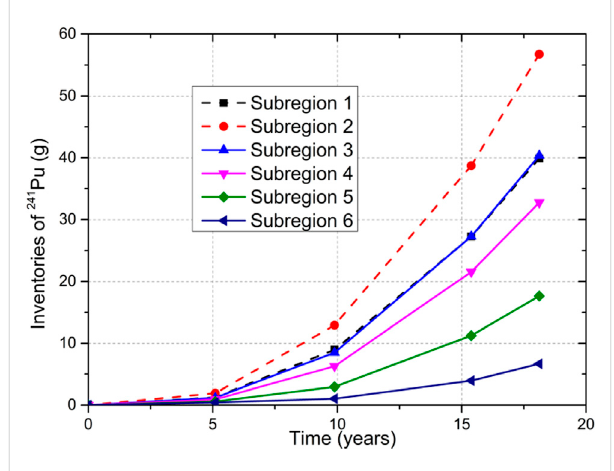
FIGURE 12 Time evolutions of 241 Pu inventories in the subregions.